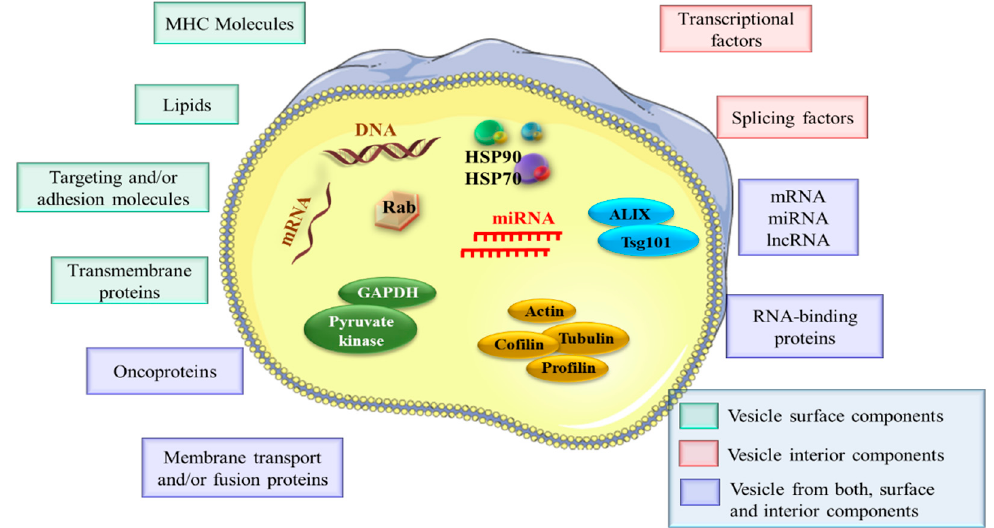
Figure 3. EV cargo profile. EVs deliver various bioactive molecules, including nucleic acids (DNA, mRNA, miRNAs (microRNAs), lncRNAs (long non-coding RNAs), specific proteins (oncoproteins), lipids, transcriptional factors, and RNA-binding proteins.